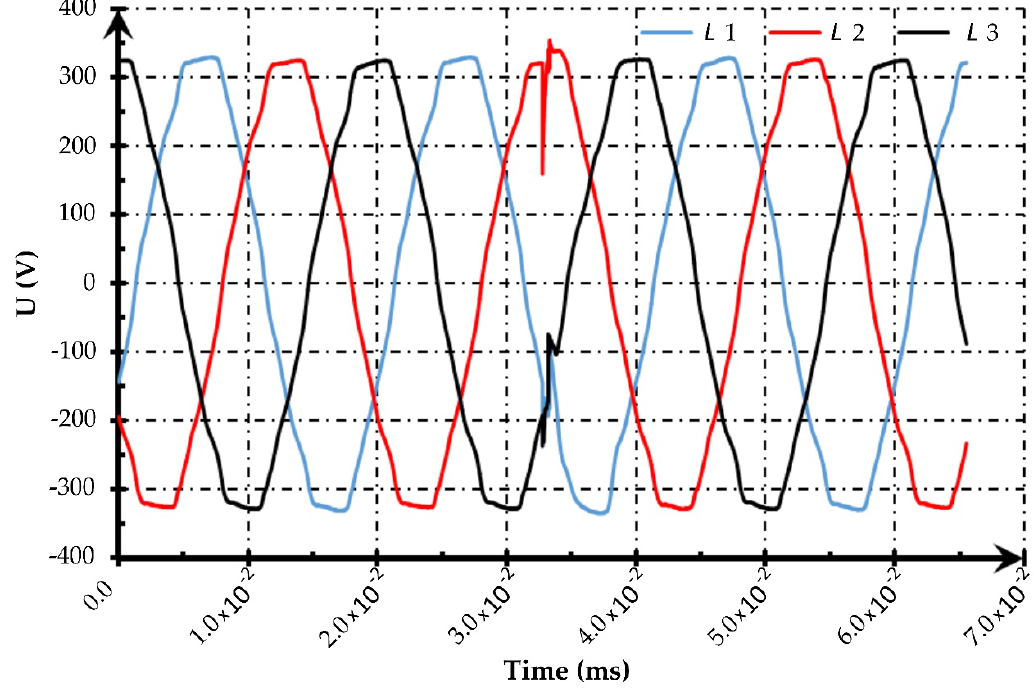
Figure 6. Rapid changes in voltage example 1.